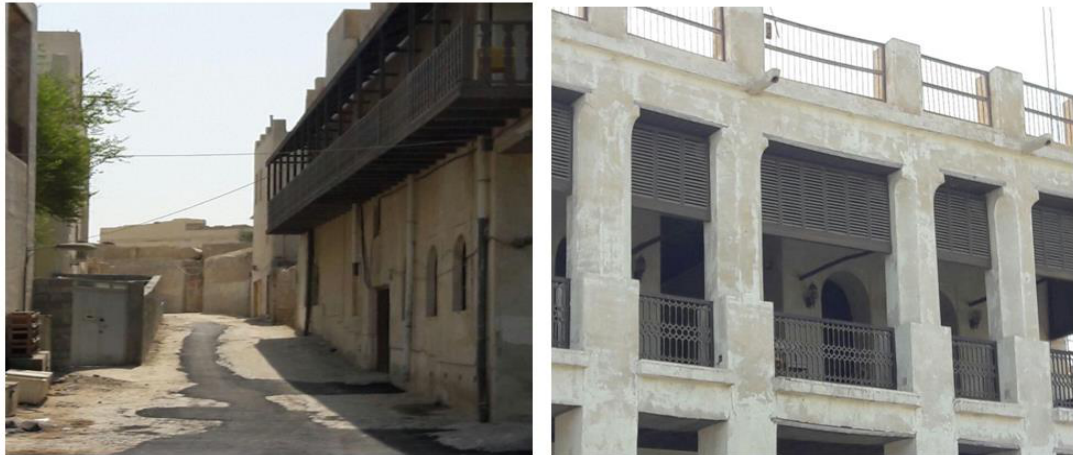
Figure 5. Using semi-open space for shading in a traditional building in Bushehr. ( left ) Using Shenashir in the outer facade for the purpose of shading, ( right ) Using a porch for the purpose of shading.